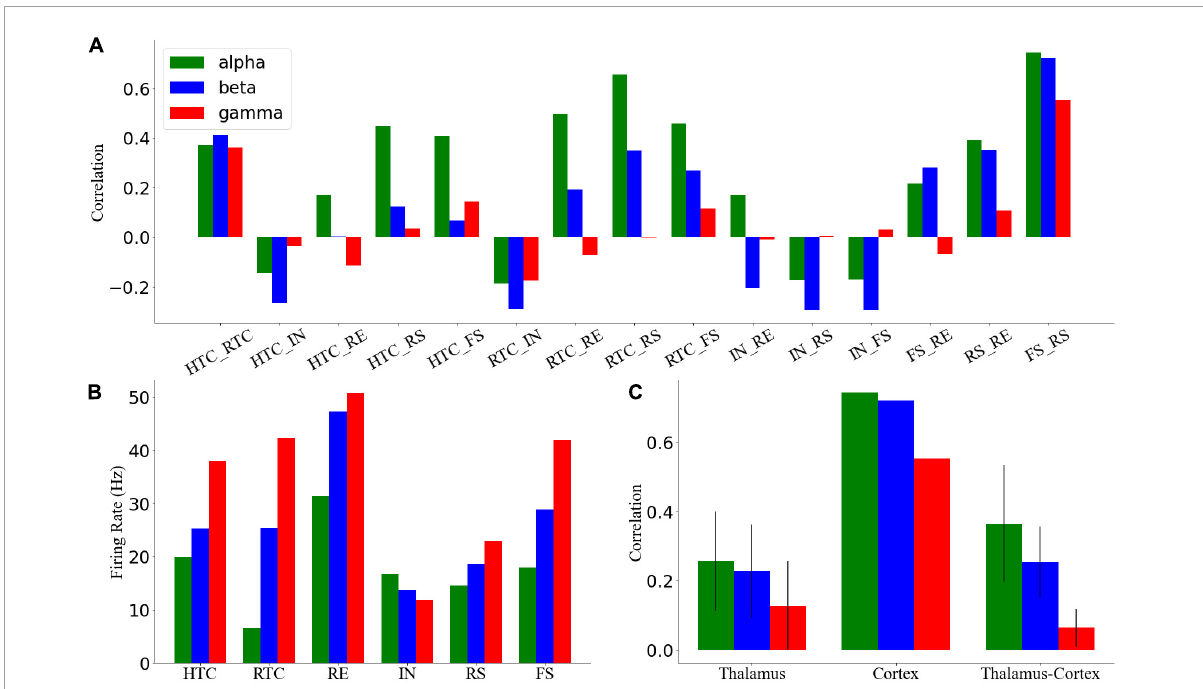
FIGURE3 Quantification of network activity. (A) Cross-correlation between each pair of the neuronal group during three oscillatory states. (B) Average firing rates of all types of neurons across three oscillatory states. Cross-correlation between different groups of thalamic neurons during four oscillatory states. (C) Average cross-correlation of the thalamus, cortex, and thalamus to cortex of neuronal groups. Error bars indicate standard